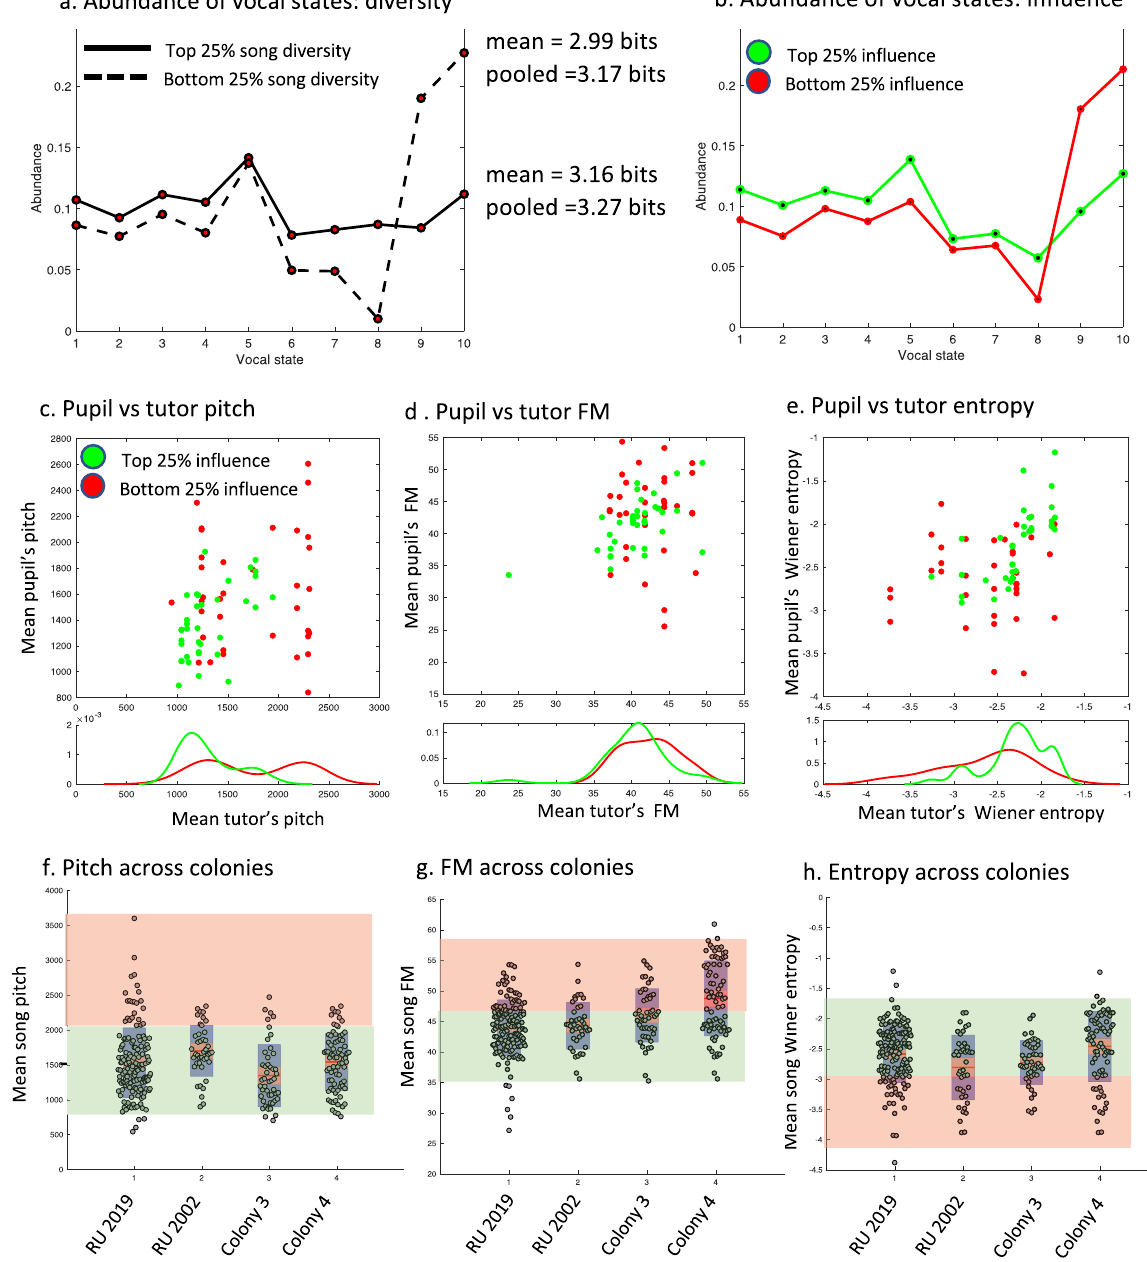
Fig. 7 Song diversity versus imitation. a Vocal state abundances in pupils pooled over birds with lowest (bottom quartile) song diversity (dotted line) vs. top quartile (solid line). b Same as a for the bottom (red) and top (green) quartiles of tutor song in fl uence. c – e Mean tutor ’ s song features versus pupil ’ s song features for pitch ( c ), frequency modulation ( d ), and Wiener entropy ( e ) for the top in fl uences (green dots, top quartile) and for bottom in fl uences (red dots, bottom quartile). Plotted at the bottom are histogram lines of tutor features for top and bottom quartiles. f – h Box plot distribution of mean song features in four colonies for pitch ( f ), frequency modulation ( g ), and Wiener entropy ( h ). Each marker represents the mean value for one bird. Green shaded areas correspond to top in fl uence feature ranges in colony RU 2019 (this study), whereas red shaded areas correspond to bottom in fl uence feature ranges in colony RU 2019 ( n = 149 birds). In the box plots themselves, the red line is the median; Orange fi ll are the upper and lower quartiles; Blue fi ll is the minima and maxima. About 20% of the RU 2019 colony are descendants from the RU 2002 colony (Rockefeller Nottebohm Lab; n = 42 birds). The remainder of the 2019 colony originated from Duke University. Colony 3 is from the University of Southern California (Bottjer Lab; n = 48) and Colony 4 is from Cornell University (Regan Lab; n = 77). Source data for this fi gure is in Supplementary Data File